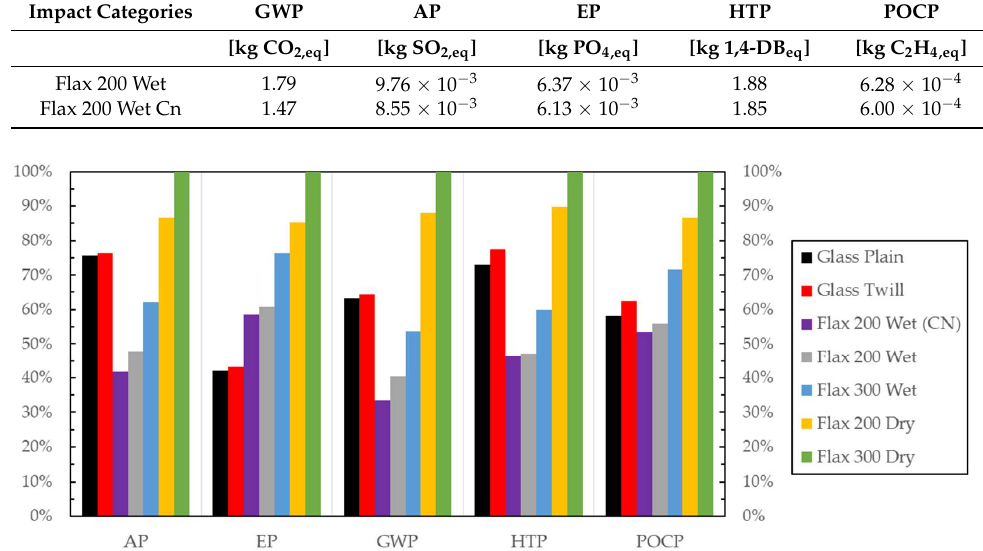
Figure 10. LCA relative indicator results of respective panel